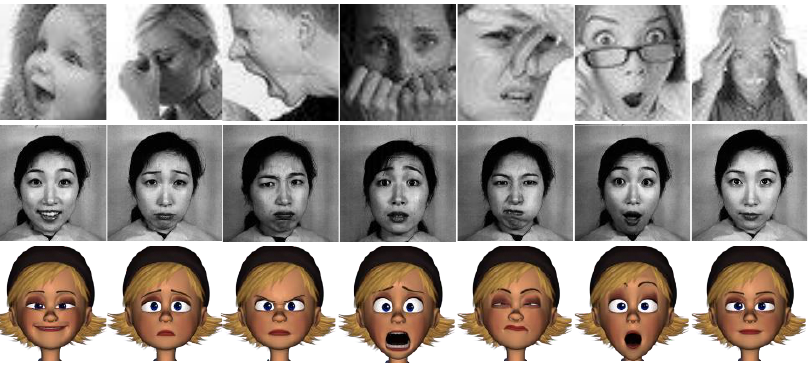
Figure 2. (Left to right) The six cardinal emotions (happiness, sadness, anger, fear, disgust, and surprise) and neutral. The images in the first, second, and the third rows belong to the FER, JAFFE, and FERG datasets,